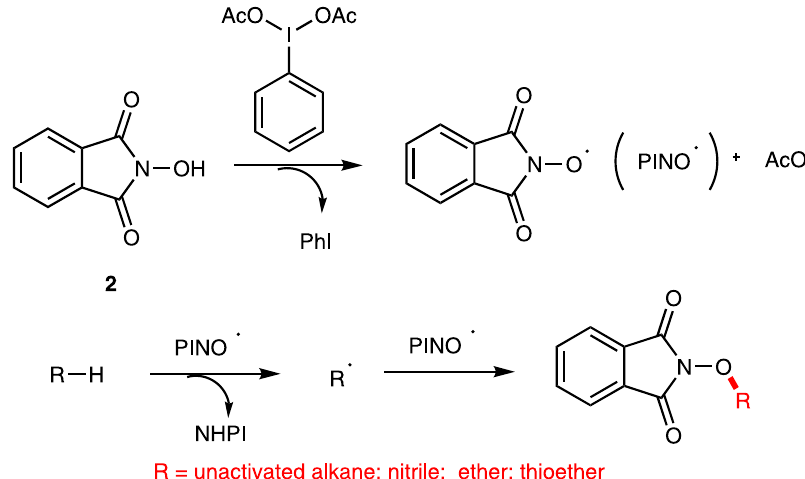
Fig. 6 Proposed reaction mechanism. Oxidation of NHPI with PhI(OAc) 2 affords PINO radical.